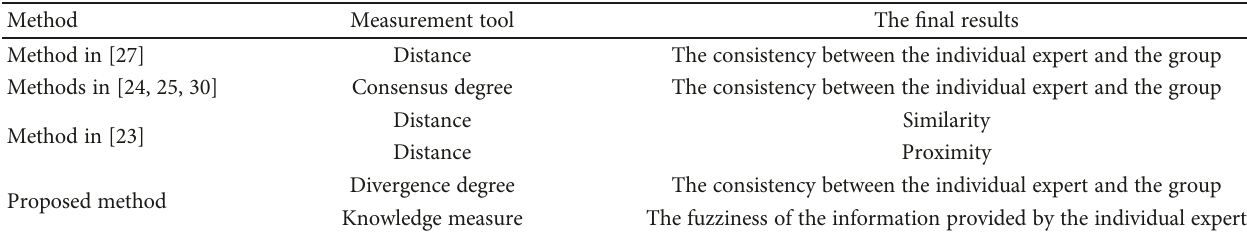
Table 16: Comparison with other existing methods for deriving the experts ’